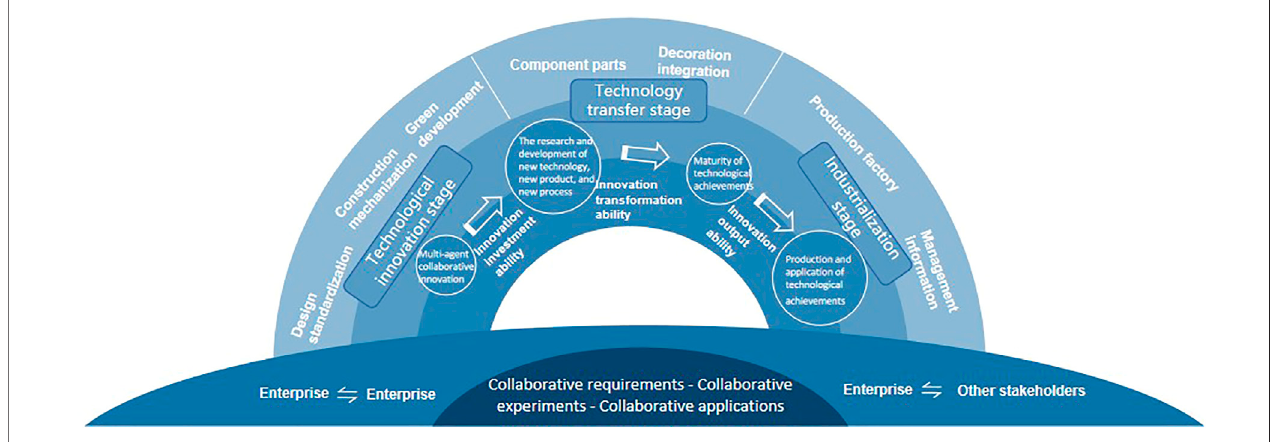
FIGURE 4 | The whole process in the collaborative development of